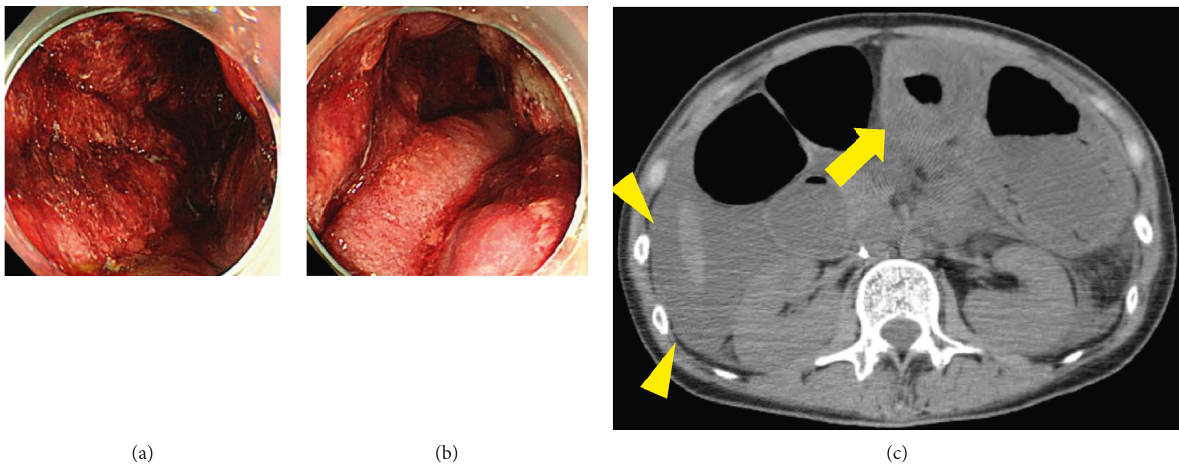
Figure 3: Phlegmonous gastritis. (a, b) Upper endoscopy. The gastric mucosa was reddish, and the folds were markedly thickened. (c) Abdominal CT. Fluid level was noted in the stomach. Arrow, thickened wall of the antrum and the pylorus with hypodense areas inside. Arrowheads,